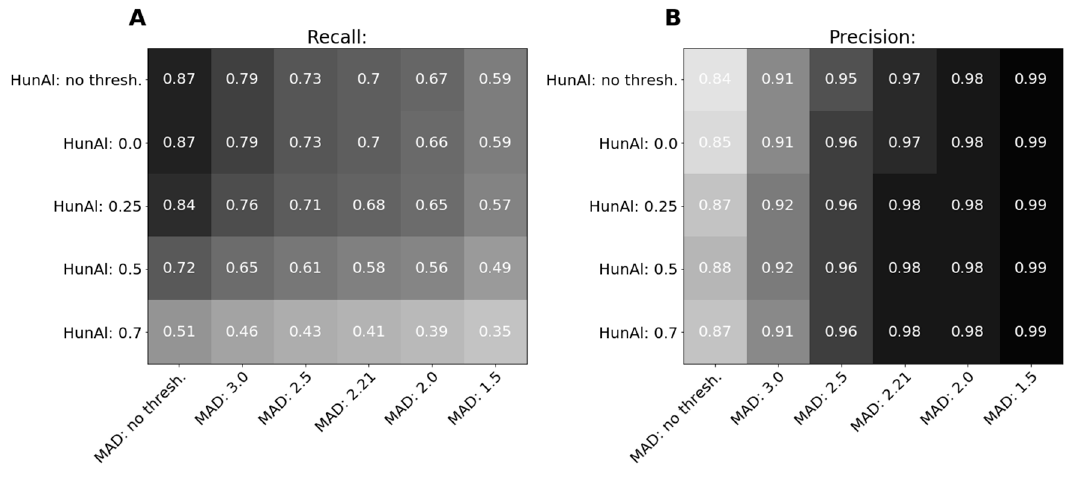
Figure A3. Evaluation on gold standard (EN–GA) for various Hunalign and MAD thresholds. The first row shows results when no threshold is set for Hunalign, and the first column shows results when no threshold is set for MAD. ( A ) Recall. ( B ) Precision.